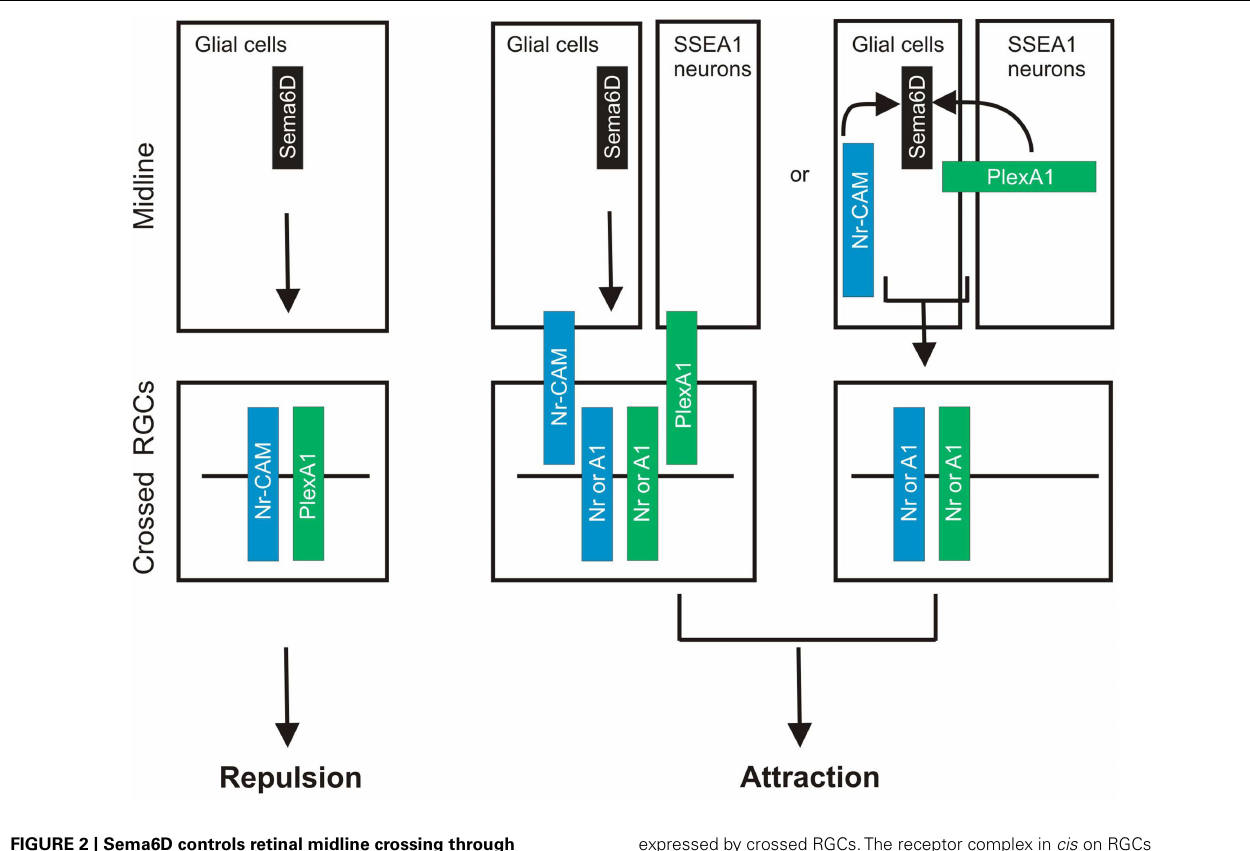
FIGURE 2 | Sema6D controls retinal midline crossing through its interaction with PlexA1 and Nr-CAM. Sema6D and Nr-CAM are expressed by glial cells in the chiasm, and PlexA1 is expressed by SSEA1 + neurons in the chiasm. Nr-CAM and PlexA1 are